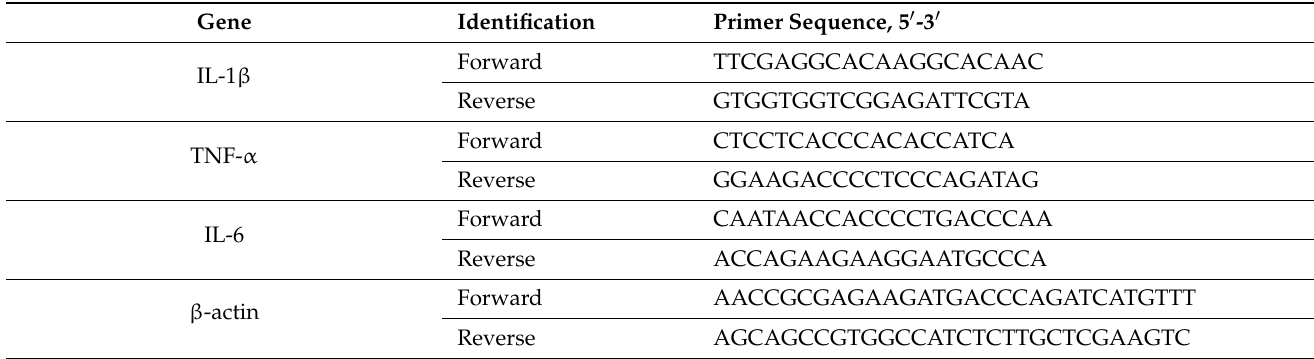
Table 2. PCR primer